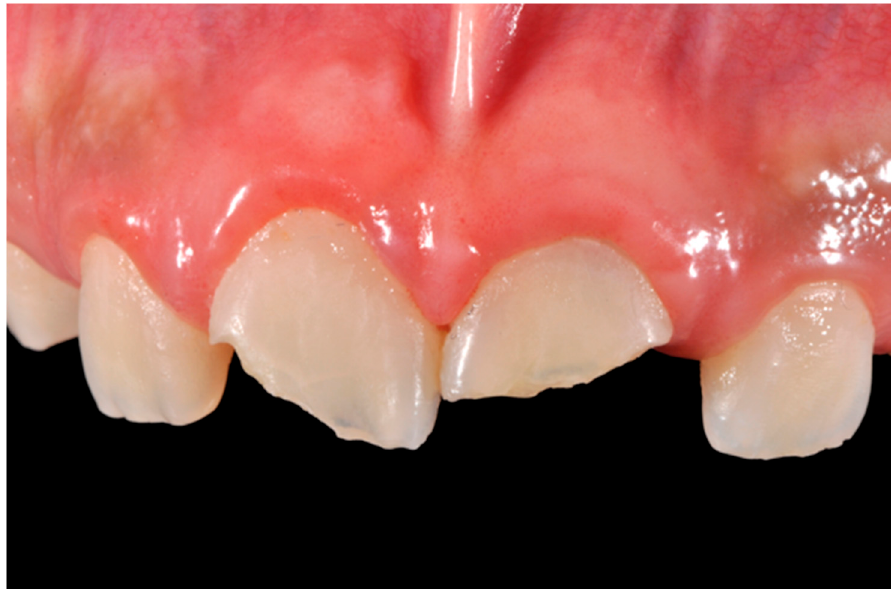
Figure 30. Initial clinical situation. Reprinted from Restauri diretti nei settori anteriori, G. Paolone, S. Scolavino, © 2021, with permission from Quintessence Publishing Italy.